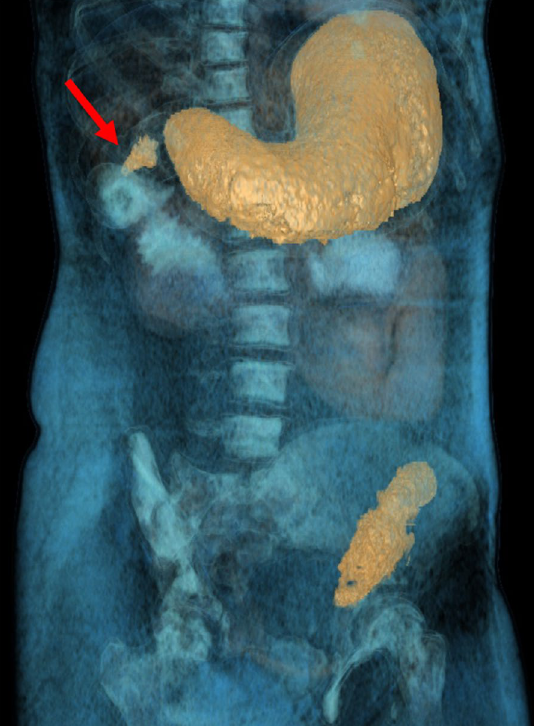
Fig. 3 Virtual CT-reconstruction of the bezoar in the stomach and the small intestine. The marked area (red arrow) indicates a possible extension into the small